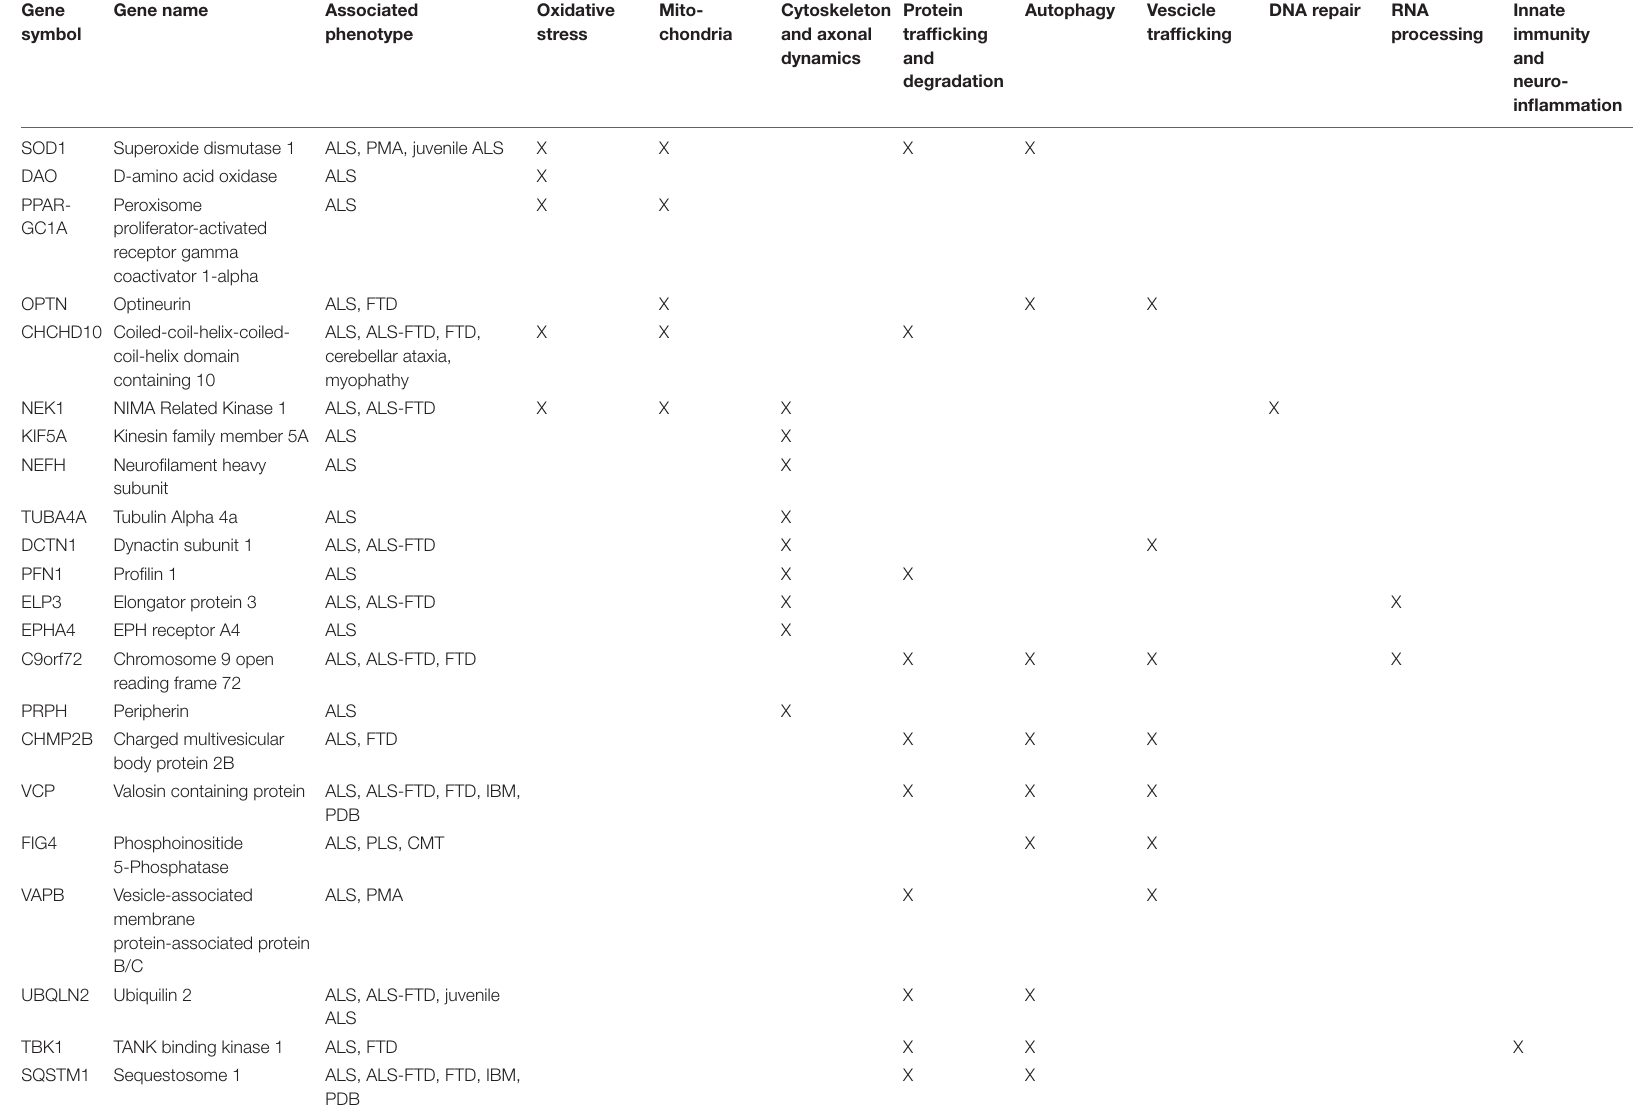
TABLE 1 | Summary of the most known genes linked to ALS, their clinical phenotypes and affected pathway. Gene symbol